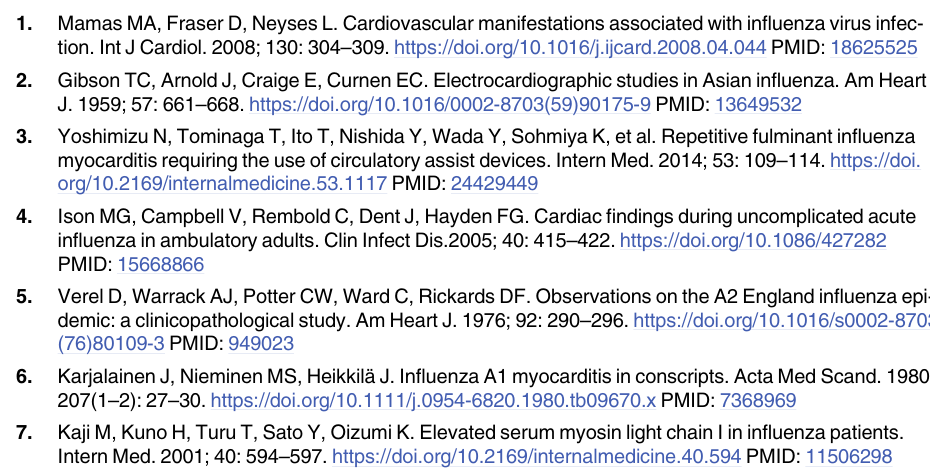
S2 Table. Raw data of patients who underwent follow-up examinations (n = 20) in addition to those of patients who had abnormal findings at the initial examinations but could not receive follow-up examinations (n =